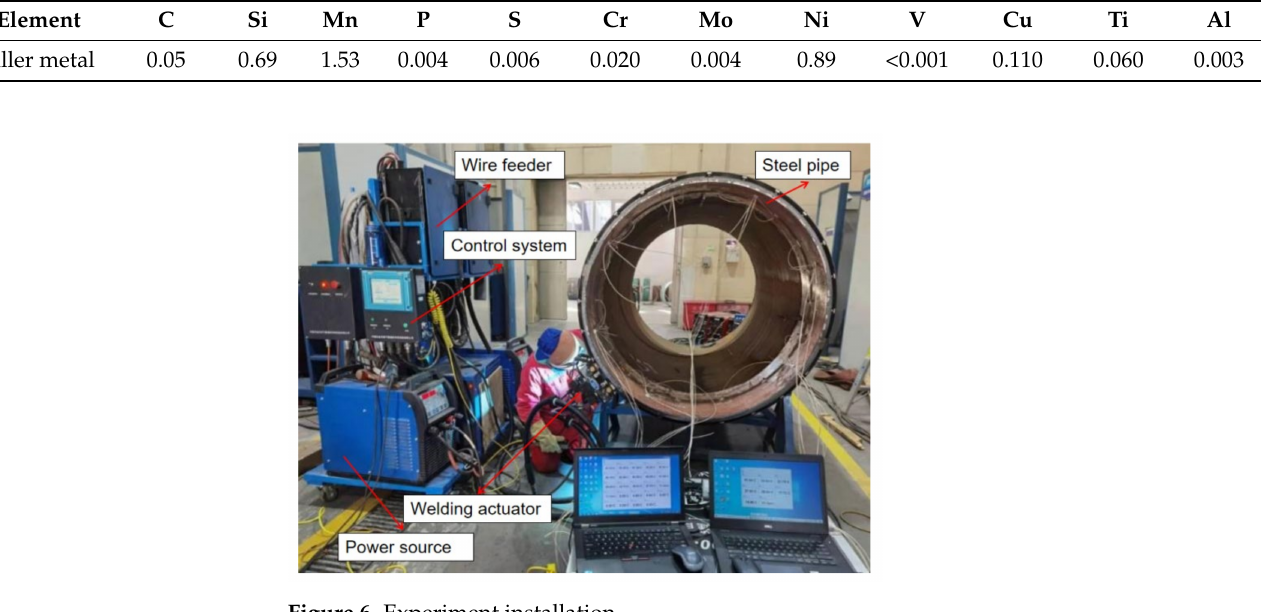
Figure 6. Experiment installation. Table 6. Welding process parameters for each